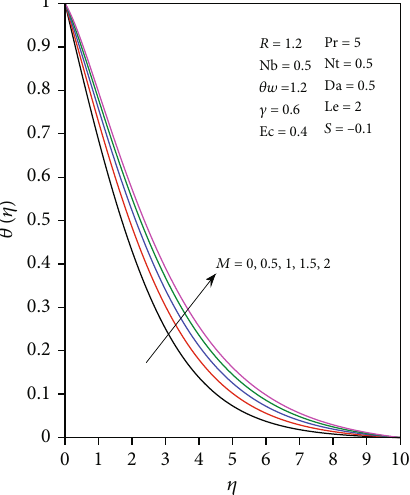
Figure 10: Temperature pro fi le for di ff erent values of M .